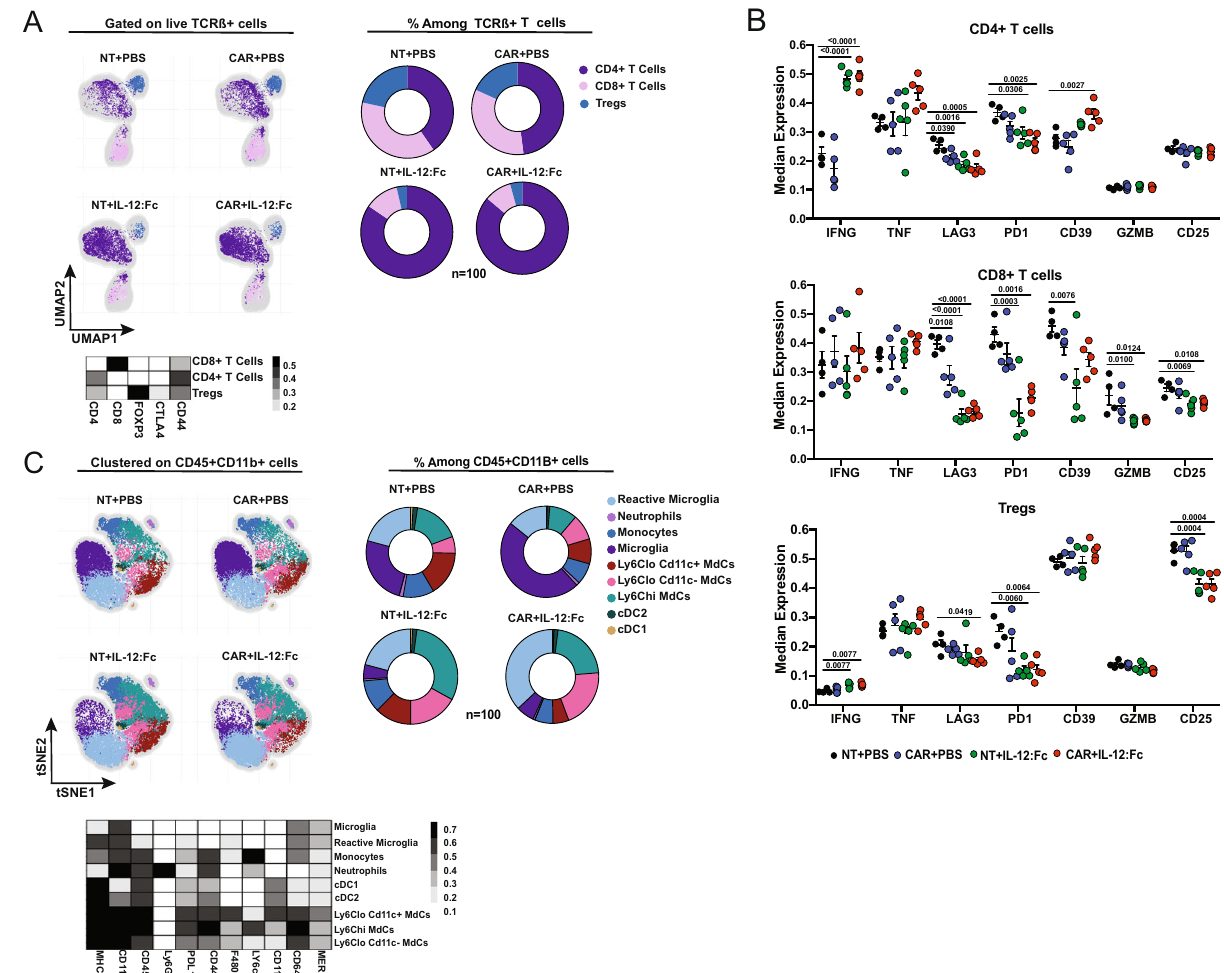
Fig. 4 IL-12:Fc reshapes the endogenous compartment within the glioma TME. A Umap showing the FlowSOM-guided metaclustering gated on TCR- β + T cells from live CD45 + cells and heatmap showing the median marker expression for each de fi ned metacluster (value range: 0 – 1) and Pie charts represent relative frequencies for the three TCR- β + T cell subclusters among total TCR- β + T cells within the different conditions (NT + PBS n = 4, NT + IL-12:Fc n = − 5, CAR + PBS n = 5, CAR + IL-12:Fc n = 5 mice, representative of n = 2 independent experiments) . B Median expression of selected cell markers shown for all TCR- β + T cell subclusters: CD4, CD8, and T regs , (NT + PBS n = 4, NT + IL-12:Fc n = 5, CAR + PBS n = 5, CAR + IL-12:Fc n = 5 mice, representative of n = 2 independent experiments). C t-SNE map showing the FlowSOM-guided metaclustering on CD11b + CD45 + cells and heatmap showing the median marker expression for each de fi ned metacluster (value range: 0 – 1) and Pie charts represent relative frequencies for the nine CD11b + CD45 + cell subclusters among total CD11b + CD45 + cells within the different conditions, (NT + PBS n = 4, NT + IL-12:Fc n = 5, CAR + PBS n = 5, CAR + IL-12:Fc n = 5 mice, representative of n = 2 independent experiments). Data are presented as mean values ± SEM. Ordinary One-way Anova with Dunnett ’ s multiple comparison test ( B ). Source data are provided as a Source Data fi